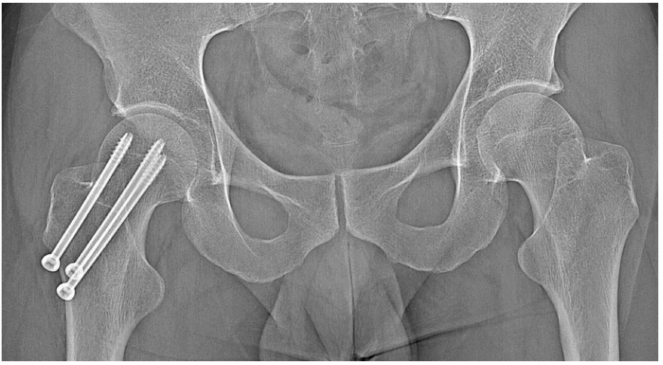
Figure 8. MRI scan of the hip joints; subtle changes (arrow) in the right femoral neck made suspicion of fatigue fracture, no focus of OO revealed initially.